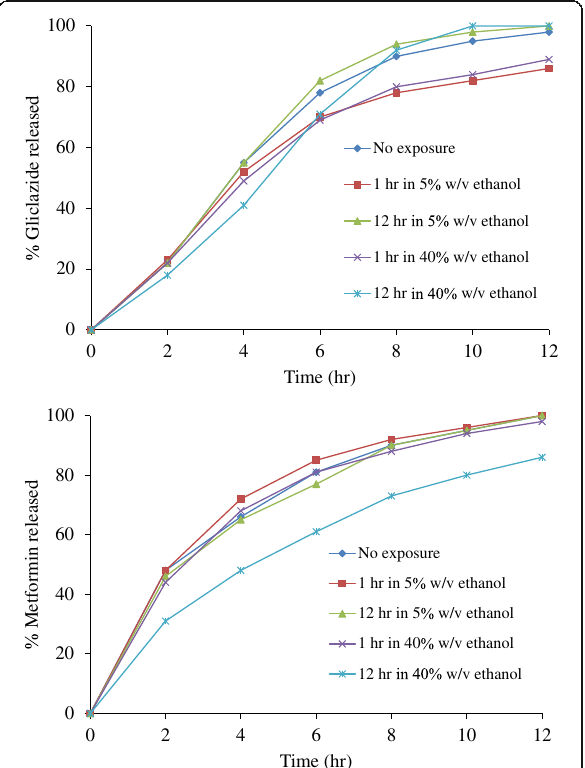
Fig. 29 Effect of alcohol on release of gliclazide and metformin from polyethylene oxide extended release matrices (data from reference (Palmer et al. 2011))